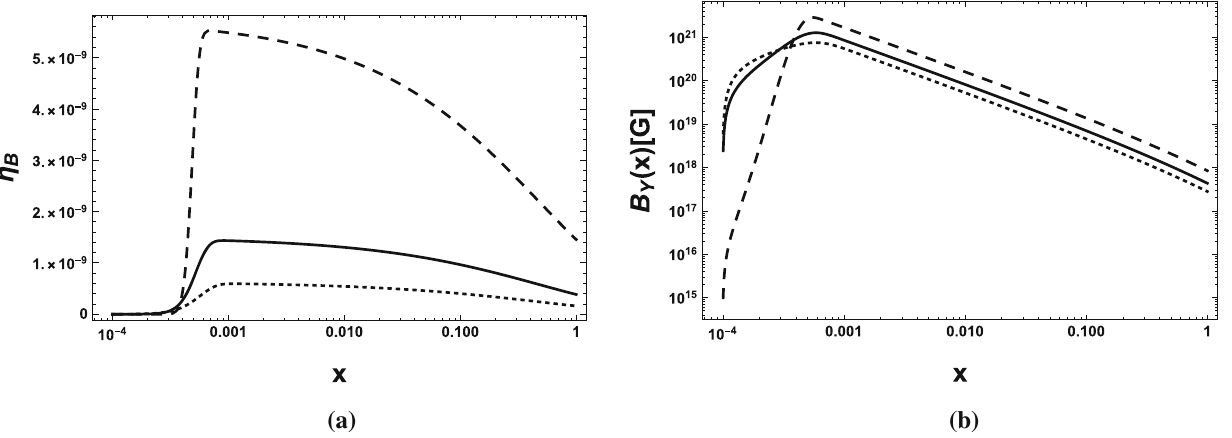
= 10 − 5 , β = 5 × 10 − 4 , and x v 0 0 obtained for b = 3 × 10 − 4 , the solid line for b = 2 × 10 − 4 , the dashed ( 0 ) = 0, η ( 0 ) = η ( 0 ) = η ( 0 ) = 0, line for b = 10 − e R e L Y B